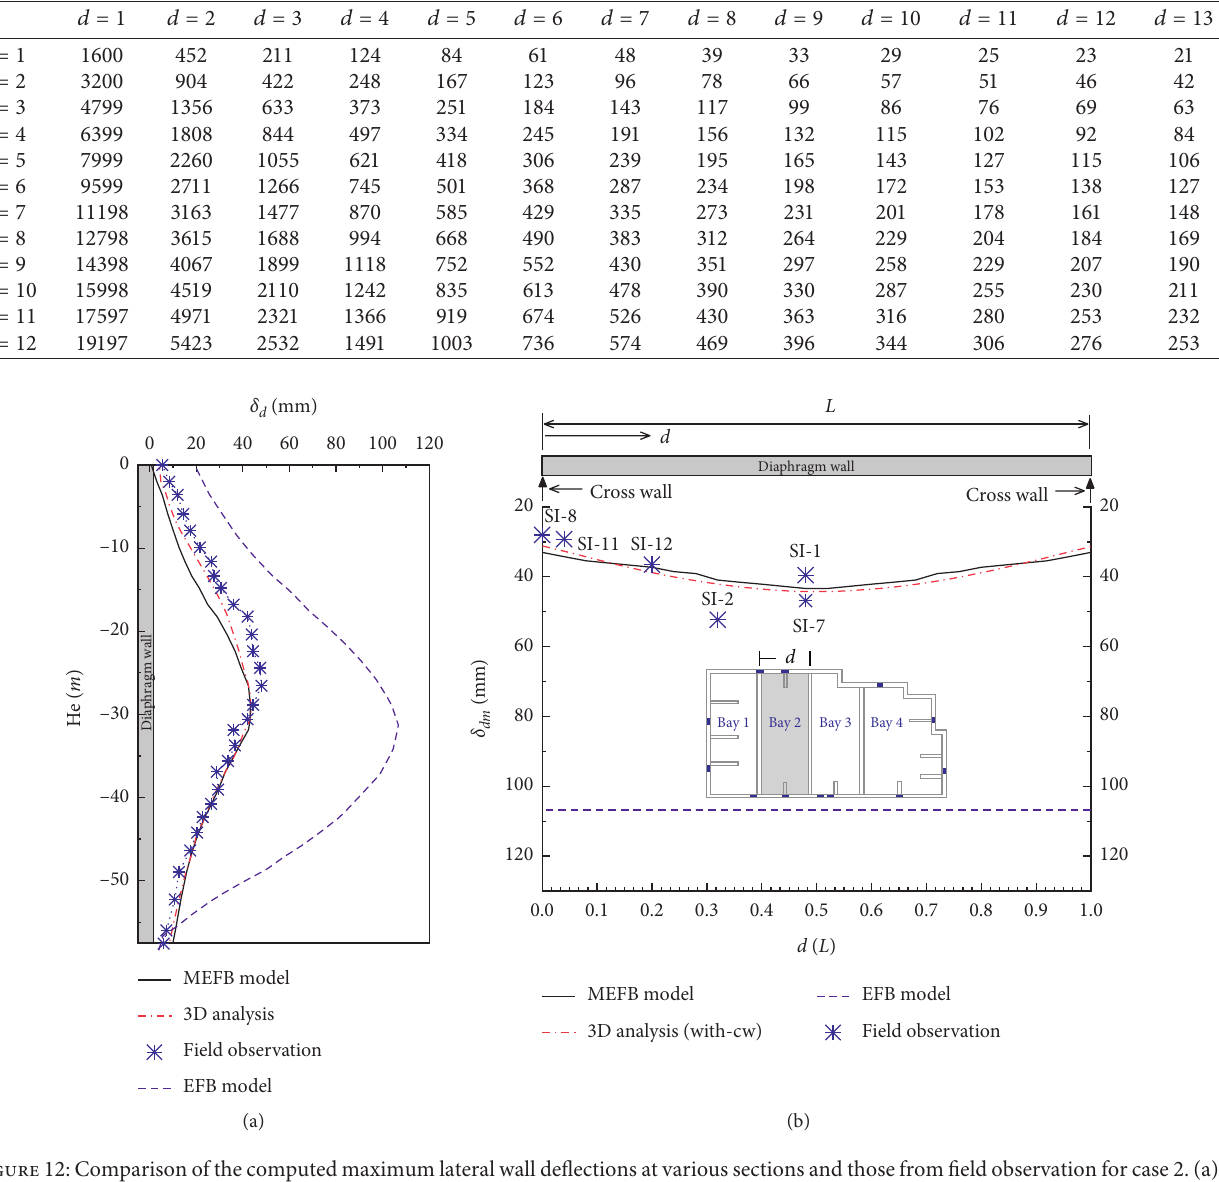
Table 4: The stiffness calculated by equation